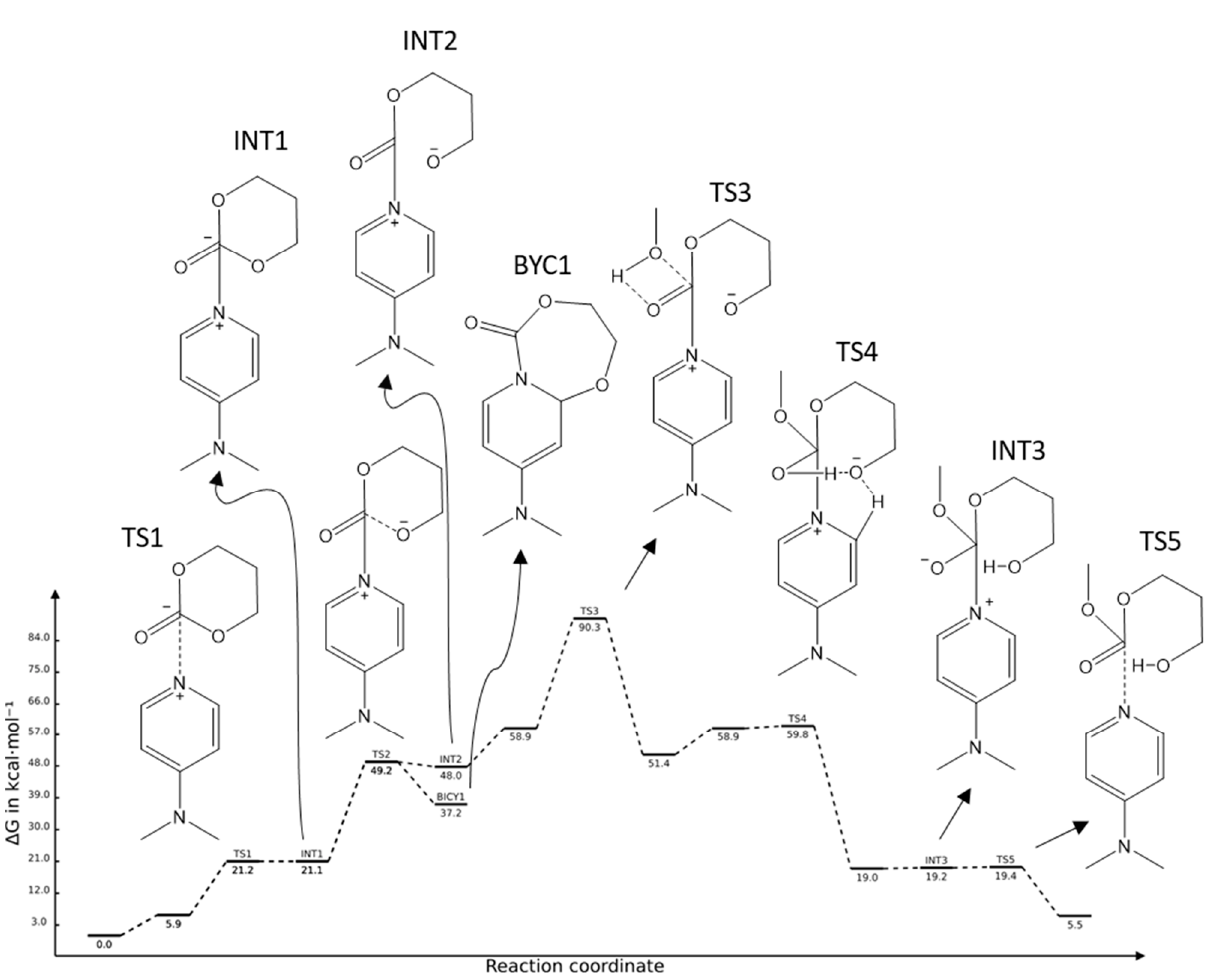
Scheme 6. Free energy profile for the nucleophilic path of the DMAP catalysed ring-opening polymerization of TMC.